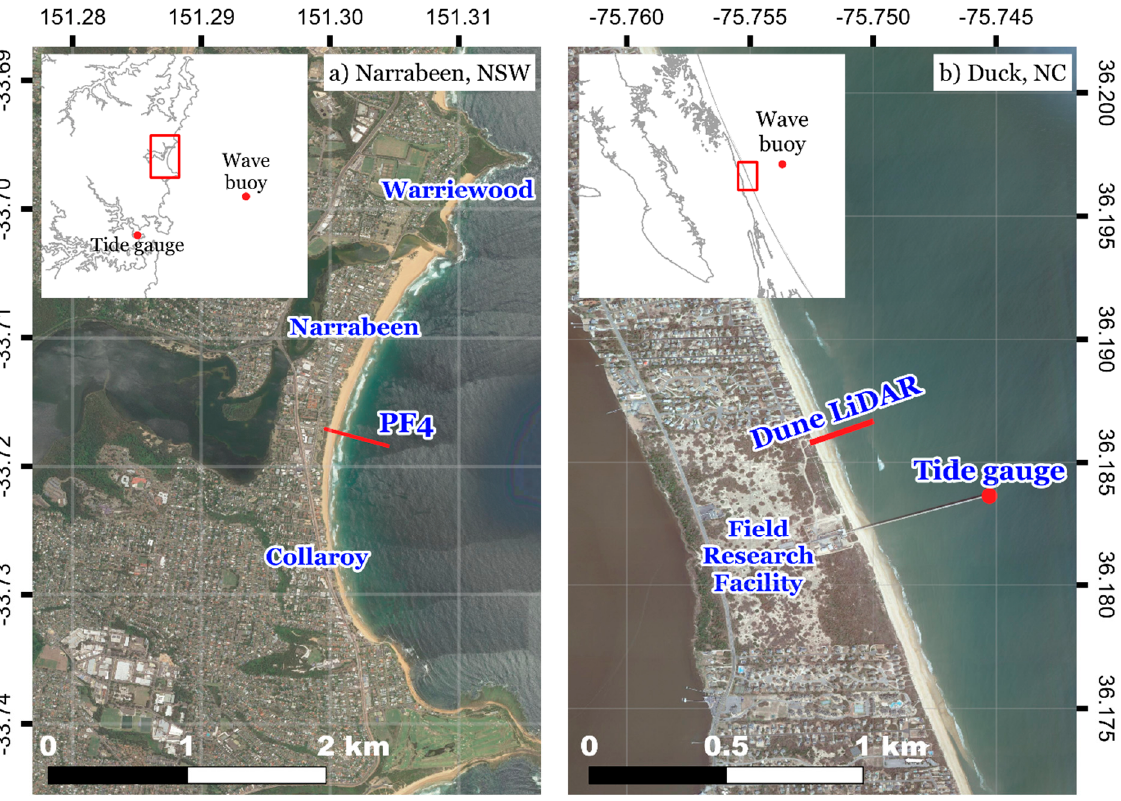
Figure 1. ( a ) Narrabeen and ( b ) Duck study sites used in this study. The cross-shore profiles used for the XBeach modelling as well as the location of the wave buoys and tide gauges from which hydrodynamic data were obtained are shown at each site.